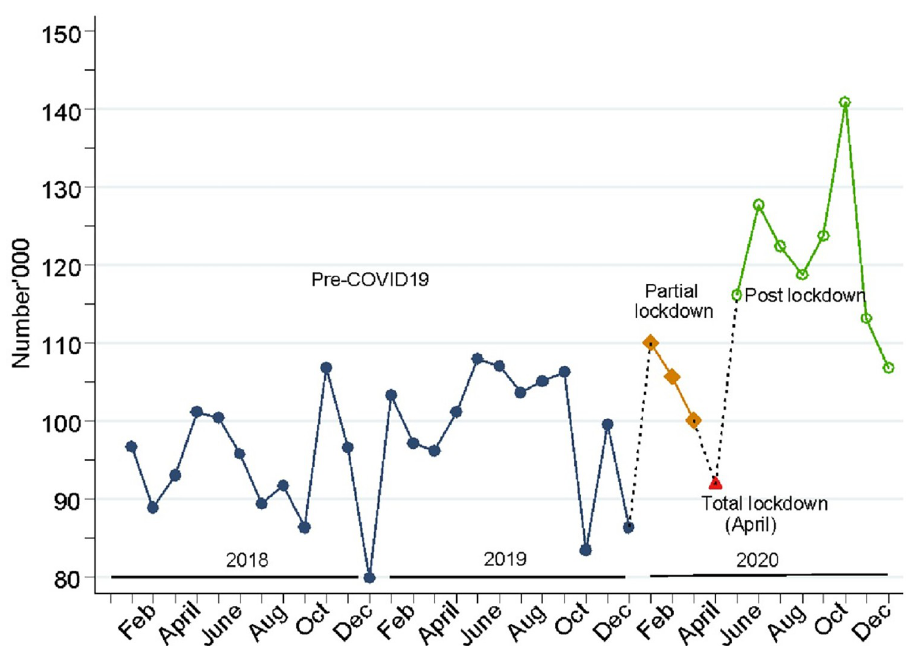
Fig 4. Trends in monthly total number of children fully immunized by 1 year in Uganda, from 2018 to 2020.